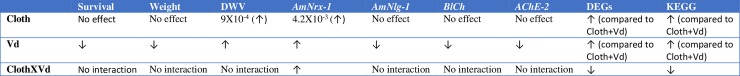
Summary of the effects of clothianidin and/or V. destructor.Effect of clothianidin (Cloth) and/or V. destructor (Vd) on honey bee survivorship, weight, DWV levels, the expression of AmNrx-1, AmNlg-1, BlCh and AmAChE-2, number of DEGs and KEGG pathways (↑ indicates an increase or up-regulation, ↓ indicates a decrease or a down-regulation).